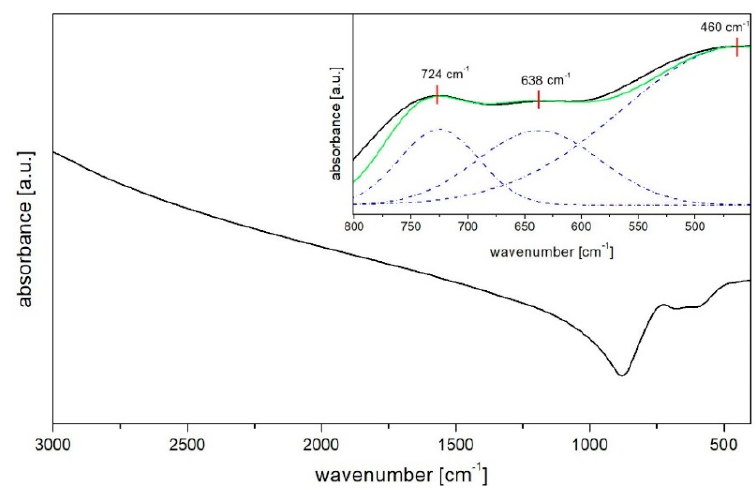
Figure 2. FTIR spectrum of host bismuth-germanate glass and (inset) decomposed 450–800 cm − 1 region.